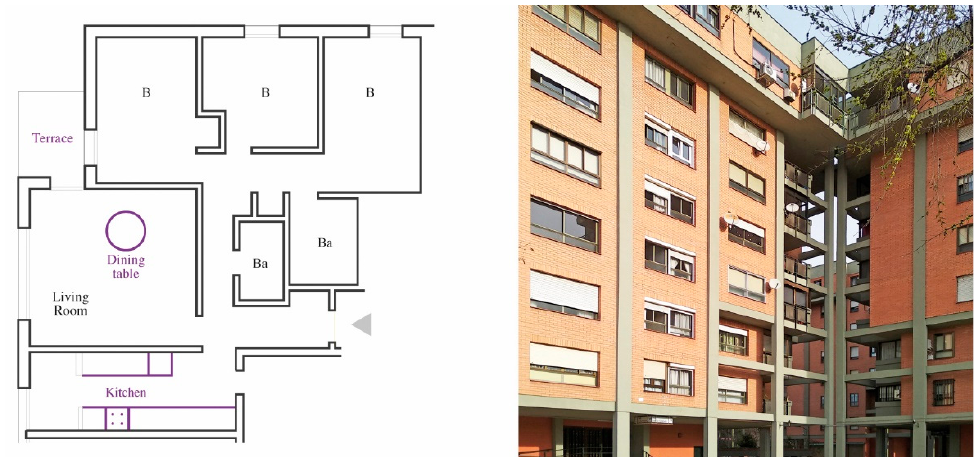
Figure 12. Palomeras housing. Three-bedroom apartment. Plan redrawn and photo by author.